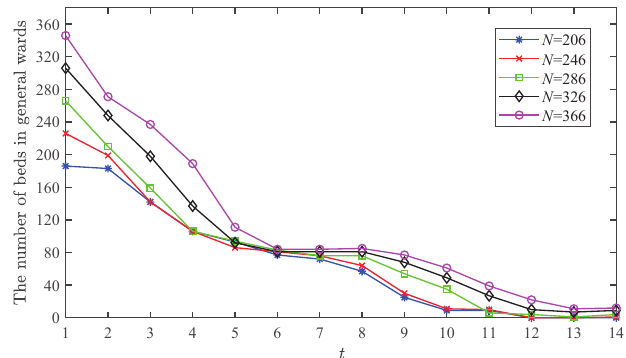
Figure 8. The number of beds in general wards in case